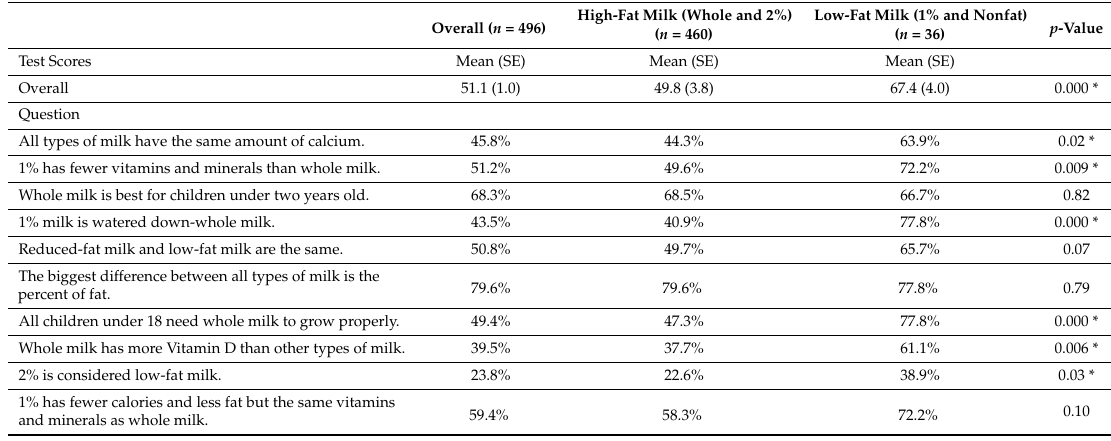
Table 1. Correct Answers to Milk Nutrition Knowledge Quiz (weighted).